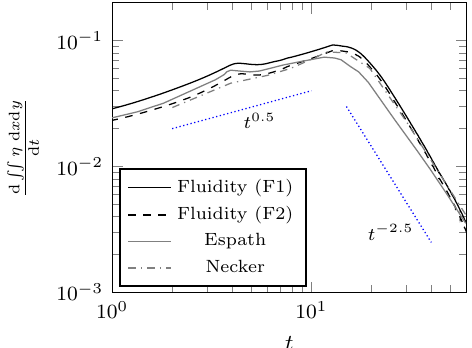
Figure 12. Deposition rates for the three-dimensional simulation. Deposition rates from Fluidity (F1), Fluidity with a modified de- position rate where the erosion rate has been removed (F2), Espath et al. (2014), and Necker et al. (2002).